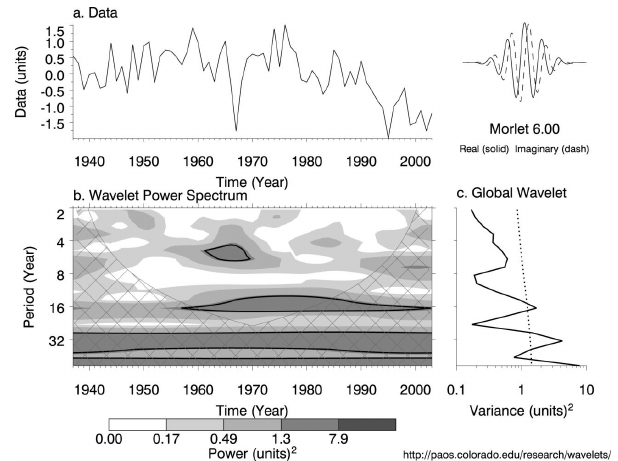
Figure 6. 616 Fig. 6. The wavelet power spectrum for δ 13 C values from de- trended and combined dataset from 1937 to 2003. The contour levels are chosen so that 75%, 50%, 25%, and 5% of the wavelet power is above each level, respectively. The cross-hatched region is the cone of influence, where zero padding has reduced the vari- ance. Black contour is the 10% significance level, using a white- noise (autoregressive lag1) background spectrum. Analyses made using IDL Wavelet Toolkit (Torrence and Compo (1998); available at: